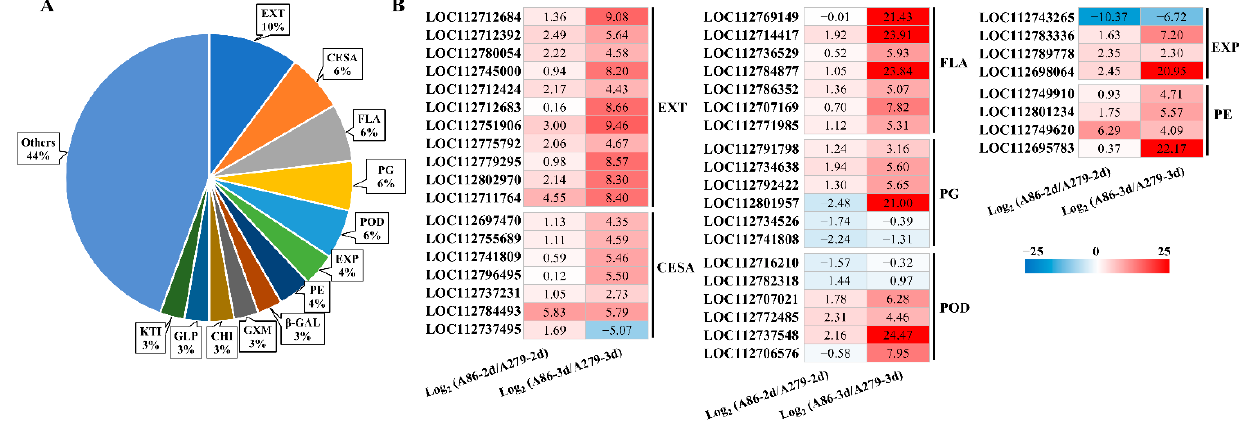
Figure 4. The expression of DEGs involved in cell wall remodeling. ( A ) Pie chart showing the frequency distribution of DEGs involved in cell wall remodeling. ( B ) Heat-map showing the differences in the expression of representative genes related to cell wall remodeling.